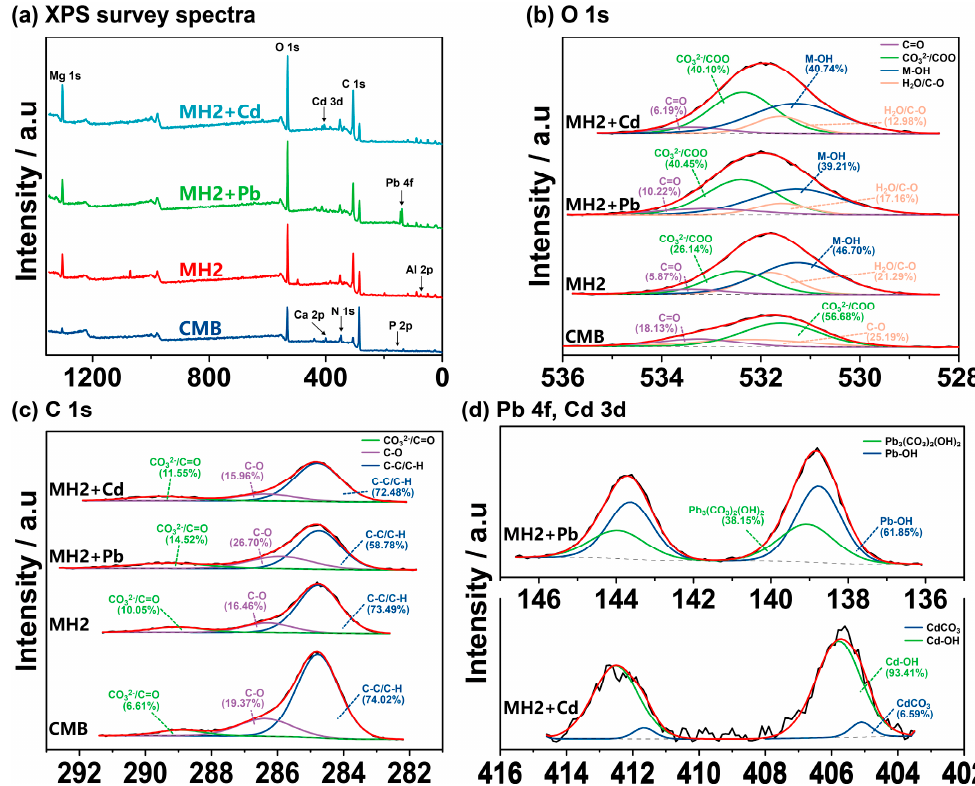
Figure 4. XPS survey spectra ( a ), high-resolution O 1s spectra ( b ) and C1s XPS spectra ( c ) of CMB, MH2, MH2 + Pb and MH2 + Cd. Pb 4f and Cd 3d spectra of MH2+Pb and MH2 + Cd ( d ). MH2, MH2 + Pb and MH2 + Cd. Pb 4f and Cd 3d spectra of MH2 + Pb and MH2 + Cd ( d